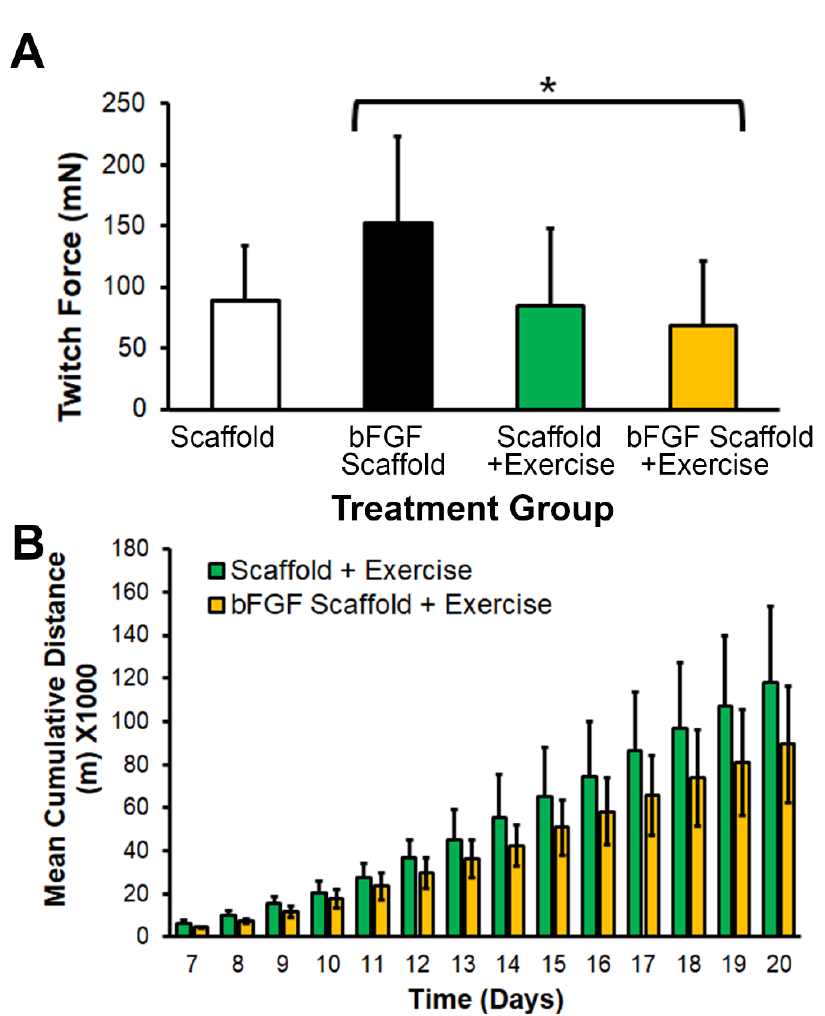
Figure 4. Functional effects of bFGF or voluntary exercise on muscle physiology or running distance. ( A ). Twitch force measurements of individual legs at 21 days after induction of VML ( n = 7–8). * denotes a statistically significant relationship between bFGF scaffold vs. bFGF scaffold + exercise treatment groups ( p < 0.05). ( B ). Mean cumulative running distance starting from 7 days after induction of VML ( n = 4 animals). Data are shown as mean ± SD.